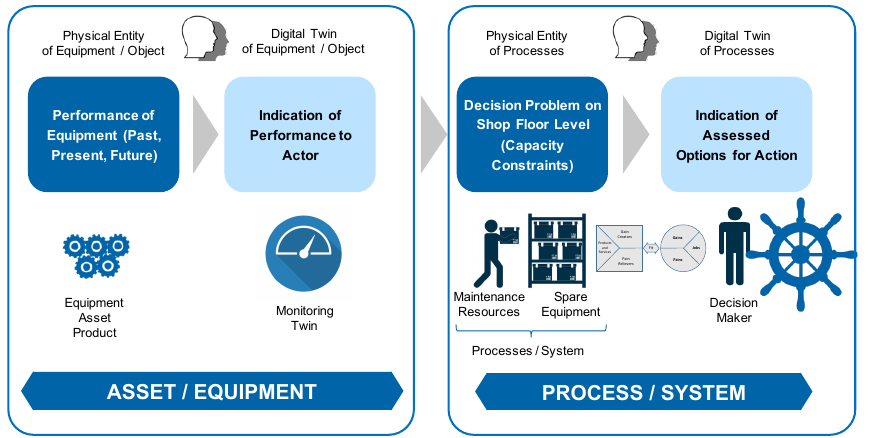
Figure 2. Digital twin of equipment vs. processes (extending on [32], terms according to [33]).